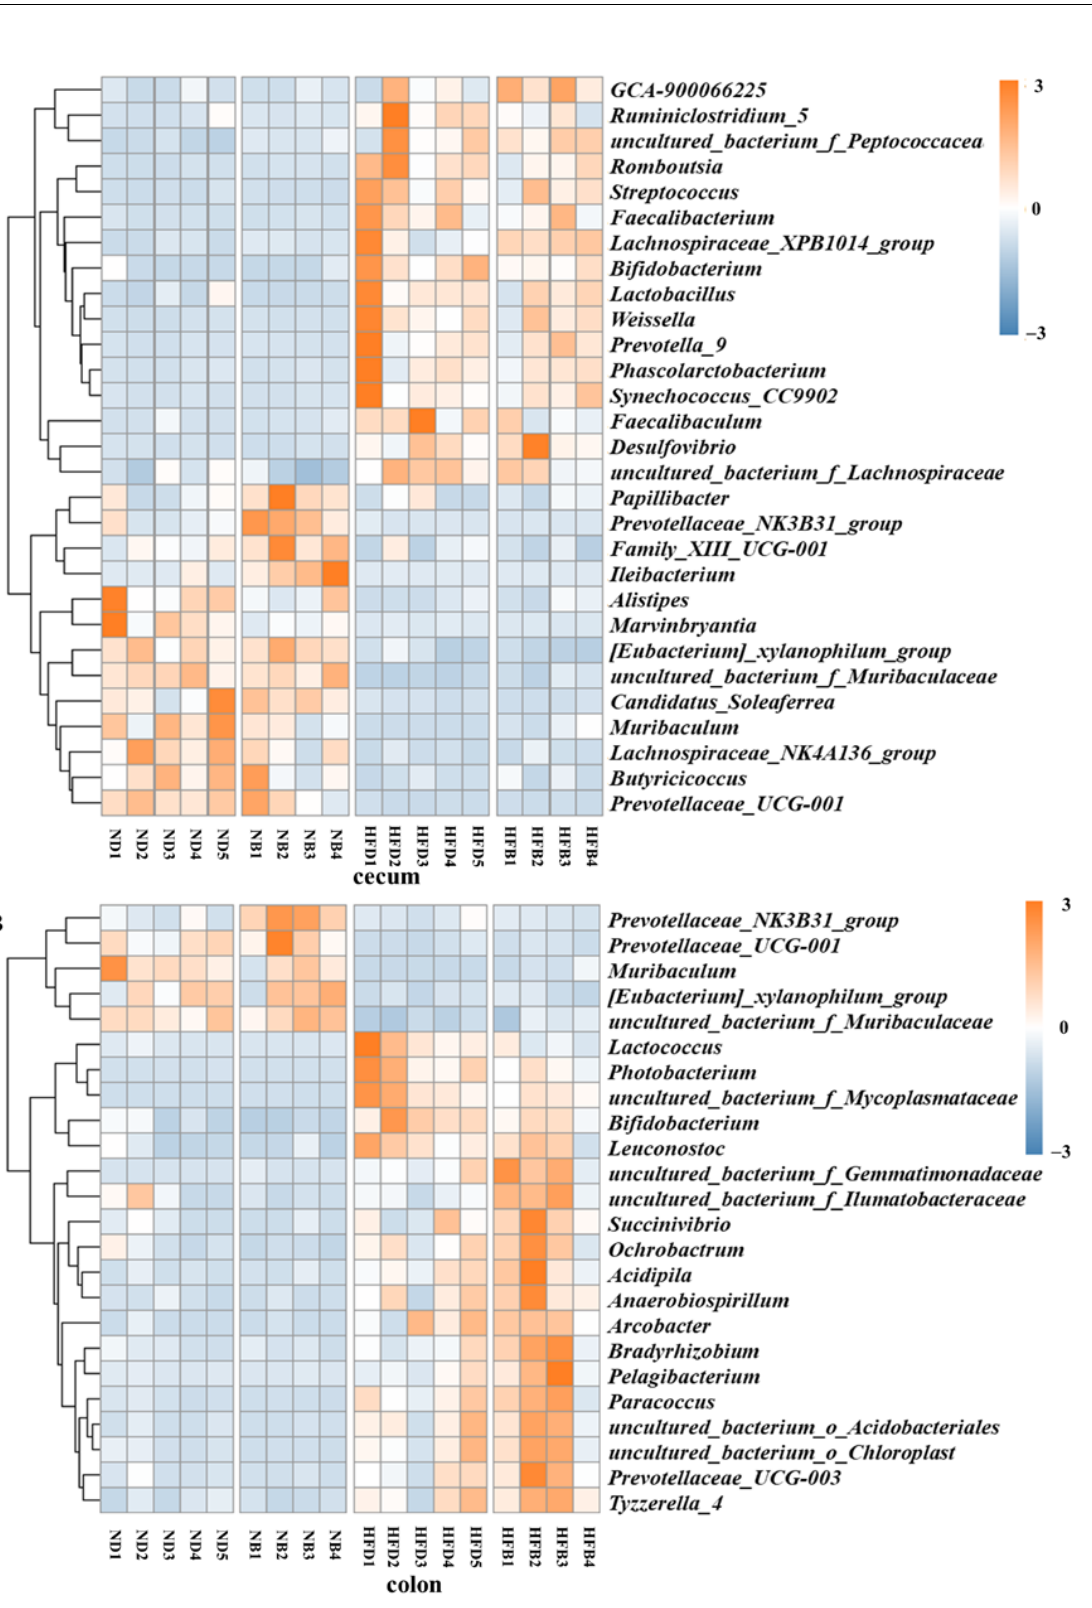
Figure 6. BCAA supplementation alters gut microbiota composition in ApoE − / − mice. Heatmap of gut microbiota composition at the genus level for each group in the cecum ( A ) and colon ( B ), n = 4–5 per group. The scale bar indicates the standardized Z value of the microbial relative abundance. Red and blue colors indicate higher and lower average expression, respectively.